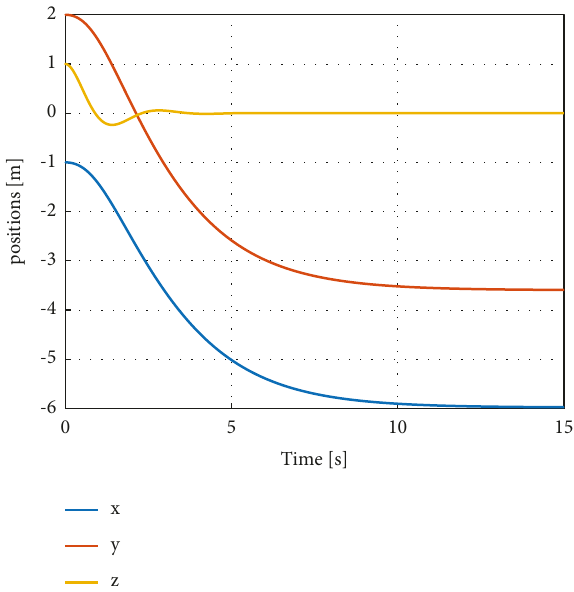
Figure 8: Positions x , y, and z as a function of time for imple- mented PD controller for attitude stabilization.